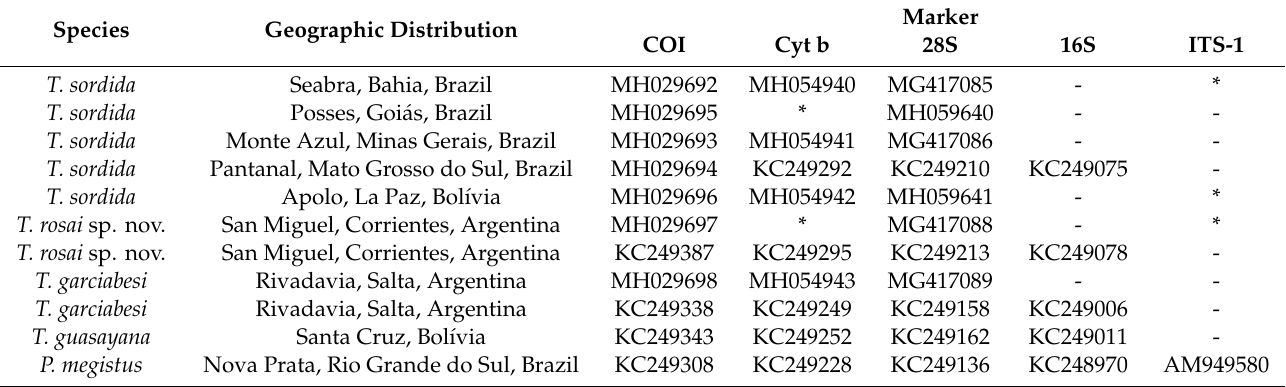
Table 1. Species, geographic distribution, and molecular markers used in the phylogenetic studies. Species Geographic